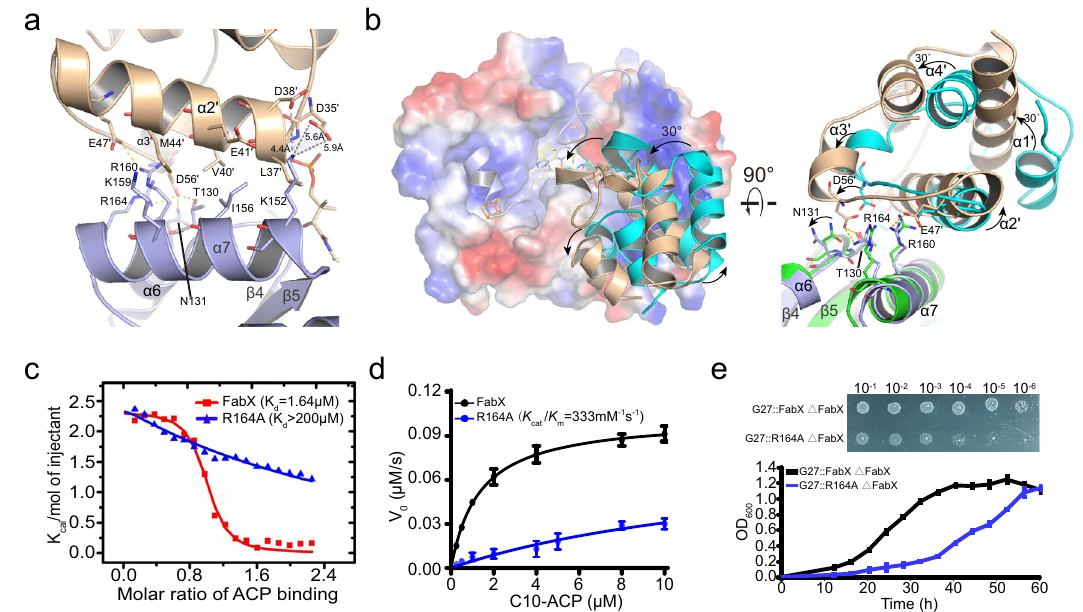
Fig. 3 Interactions between FabX and ACP. a Interactions between octanoyl-ACP (wheat) and FabX (light blue). Residues involved in the binding are shown in sticks and labeled. The primes indicate an ACP residue. Yellow dashes indicate hydrogen bonds between FabX and ACP residues. Gray dashes indicate the absence of hydrogen bonds that are normally observed in ACP – enzyme complexes of FAS-II pathways, and the distances are labeled. b Superposition of FabX – holo-ACP complex (green/cyan) with FabX – octanoyl-ACP complex (light blue/wheat). The electrostatic surface of FabX bound by octanoyl-ACP (wheat) or holo-ACP (cyan) is shown. Half of the active site tunnel inner surface and the secondary structures of [4Fe – 4S] cluster are shown. The black arrows indicate the rotation direction of the secondary elements or the sidechains of residues between the two complexes. The FMN cofactor and H182 were also shown in sticks and labeled. c Isothermal titration calorimetry (ITC) determination of holo-ACP binding to FabX (red) or FabX R164A variant (blue). d Kinetic characterization of FabX (black) or FabX R164A (blue) dehydrogenase activity in catalyzing decanoyl-ACP. N = 3 biologically independent experiments. Data is presented as mean ± SD. e The growth phenotypes of the strains BHKS487 (G27 IR0203:: fabX Δ fabX ) and BHKS488 (G27 IR0203:: fabX R164A Δ fabX ). The strains were cultured in BHI medium containing 10% FCS and Columbia blood agar plates containing 5% FCS, respectively. N = 3 biologically independent experiments. Data is presented as mean ± SD. Source data are provided as a Source Data fi